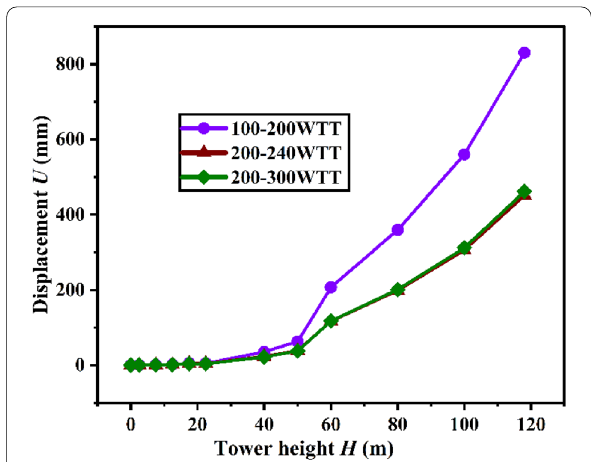
Fig. 9 Displacement distribution of UHPC segment in towers with various wall thickness